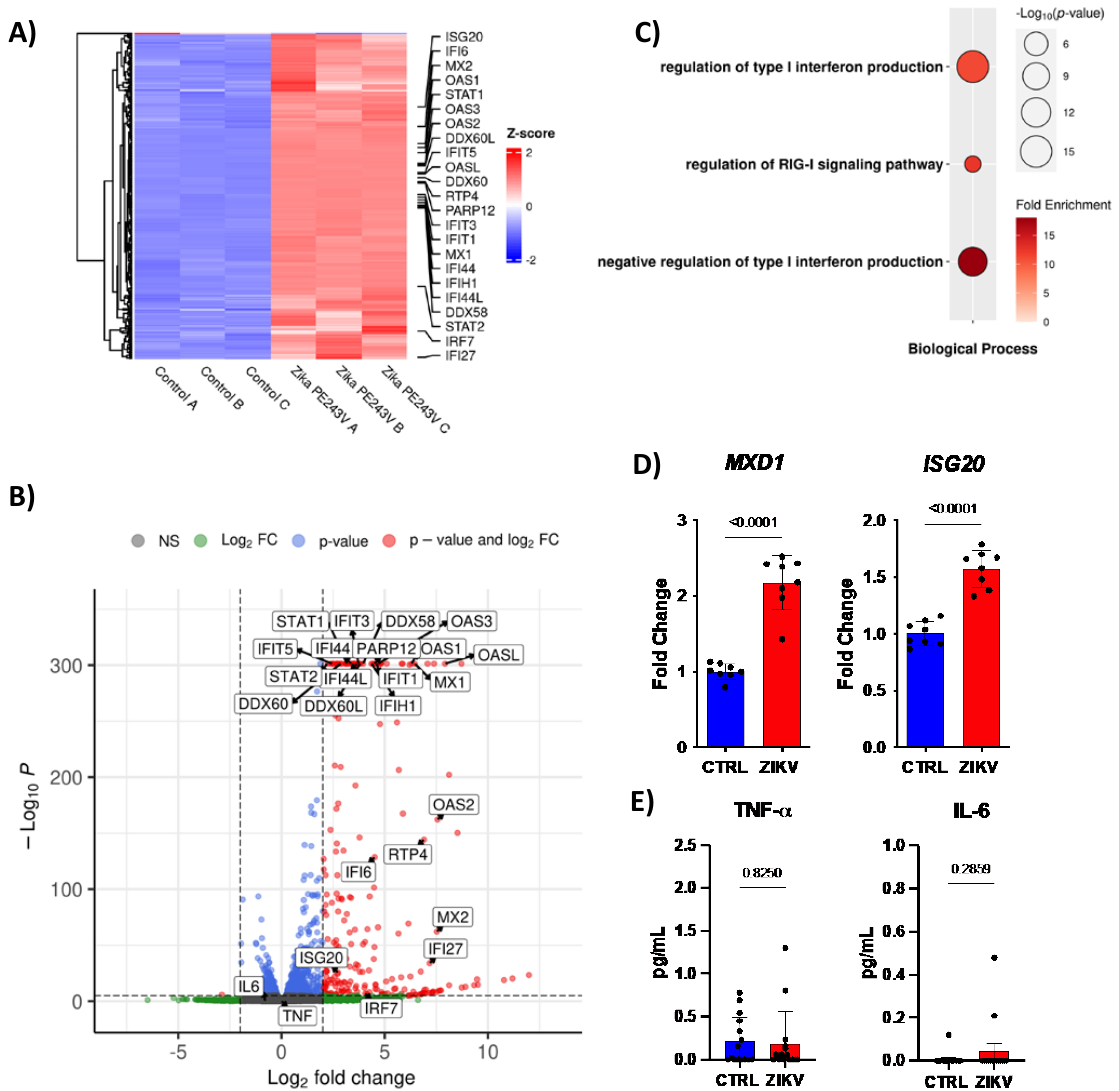
Figure 5. ZIKV downregulates miRNAs to modulate antiviral immune response. ( A ) Heat-map, ( B ) Bubble plot of gene ontology, and ( C ) volcano plot of public RNA-sequencing from hiNPCs (n = 3). 31,040 variables. ( D ) Gene expression of MXD1, and ISG20 by qPCR (n = 8), and ( E ) Quantification of TNF − α , and IL − 6 by CBA in supernatant of CTRL or ZIKV infected human NPCs after 48 h post infection (n = 12). Graphs represent three independent experiments. Unpaired t